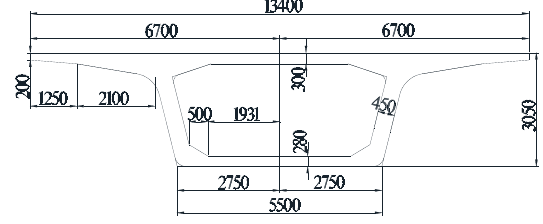
Figure 2. Mechanical model of the ballastless track–bridge structure.